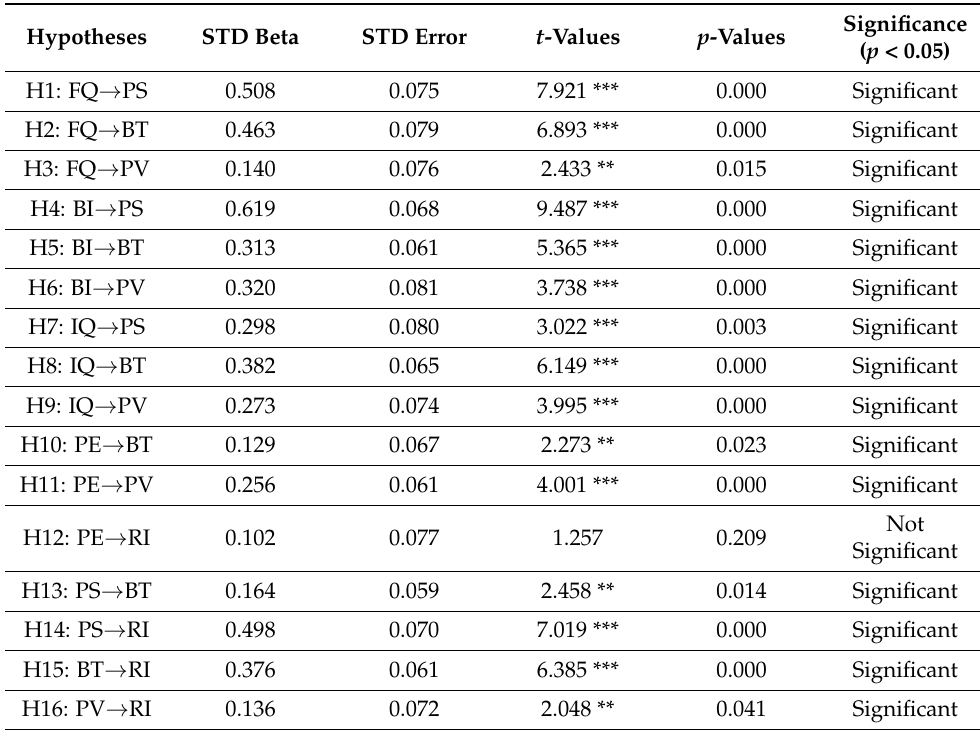
Table 6. Structural model and hypothesis testing